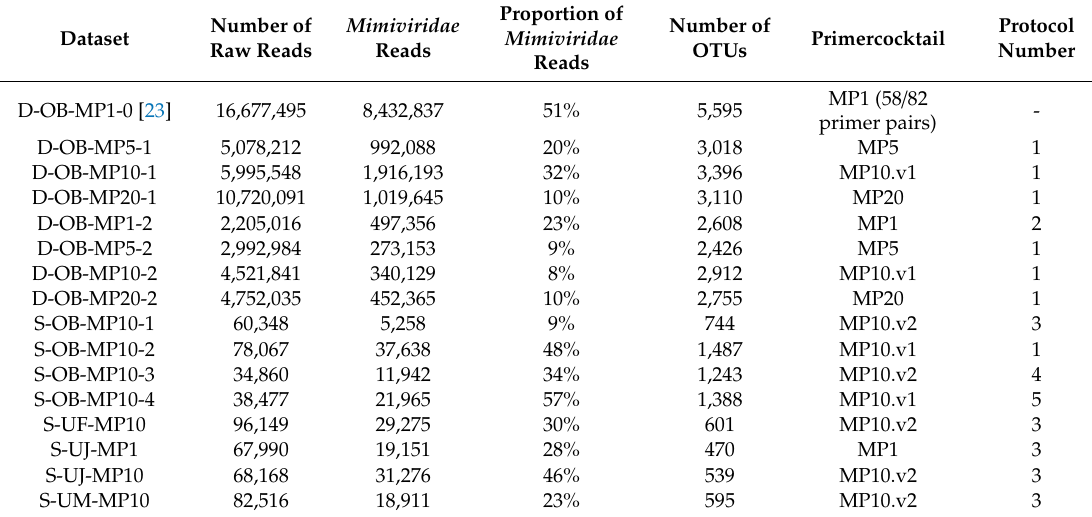
Table 2. Overview of the generated Mimiviridae polB amplicon